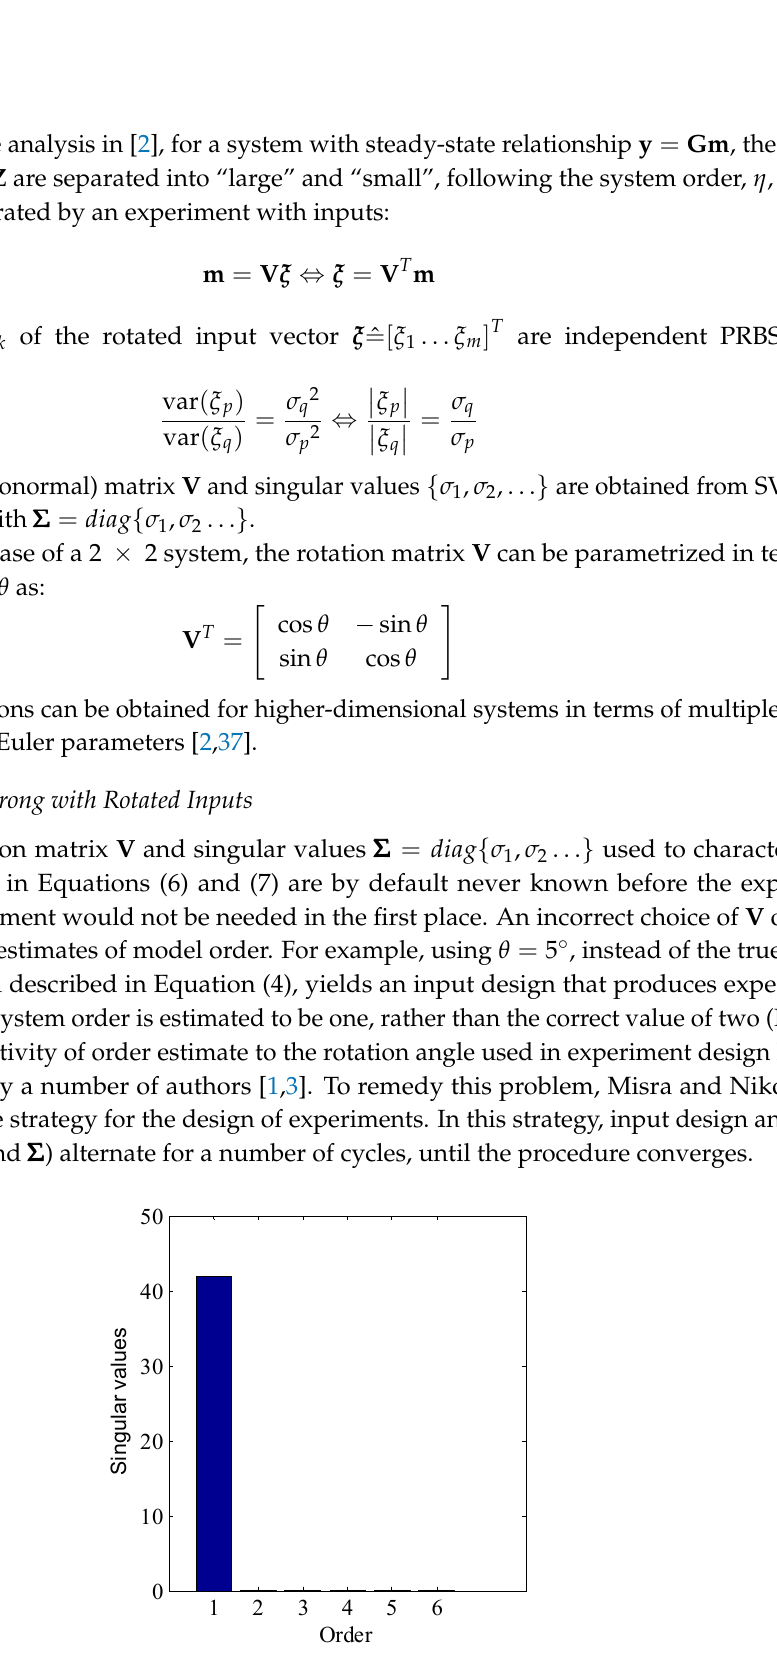
Figure 3. Model order estimation for 2 × 2 distillation column using experimental data from a process excited by rotated PRBS inputs at the wrong rotation angle of 5 ◦ in place of the correct rotation angle of 40 ◦